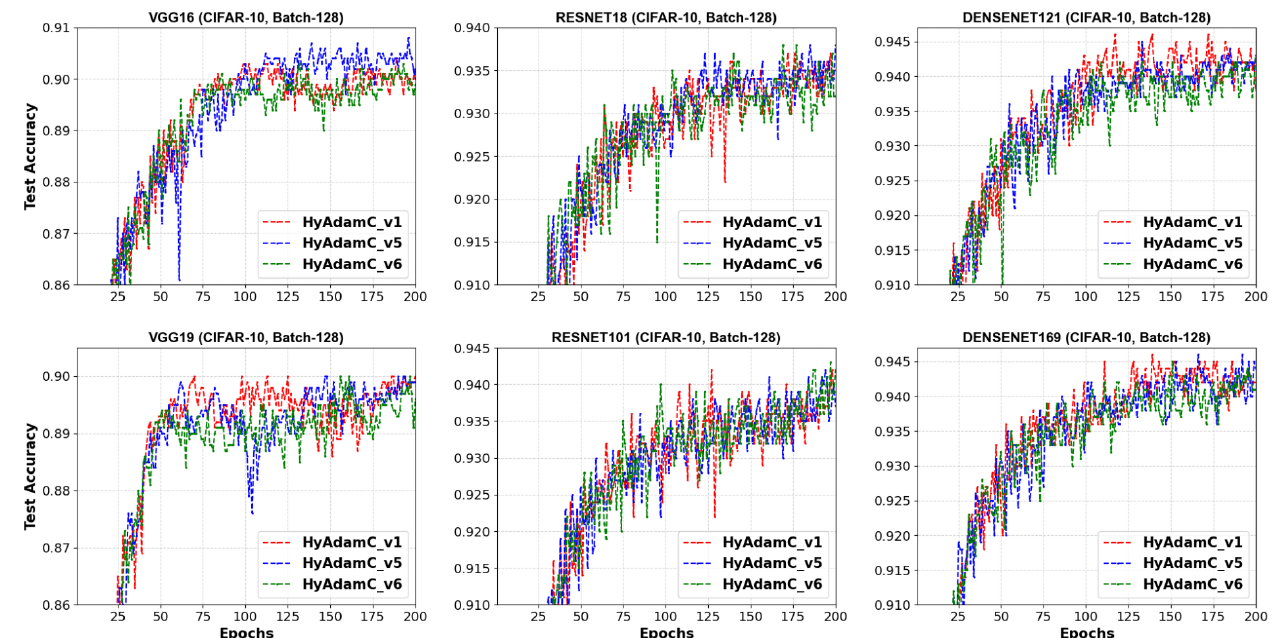
Figure 12. The test accuracy curves of VGG, ResNet, and DenseNet trained by HyAdamC-v1, v5, and v6 with CIFAR-10 images in the 128-batched